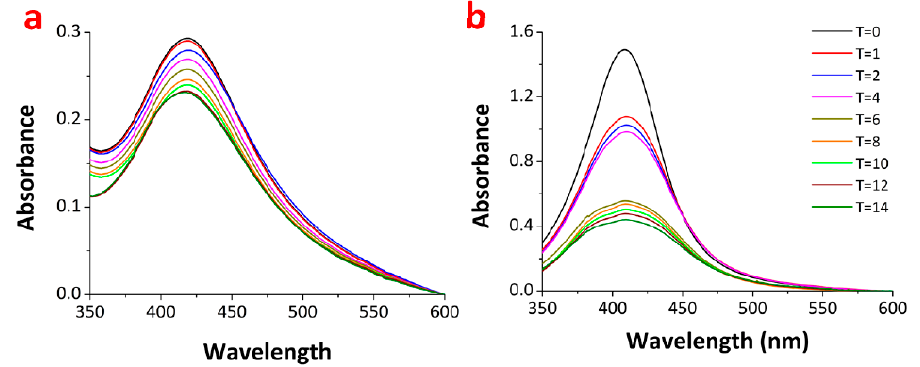
Figure 12. UV-vis spectra of the nanocomposites with the ratio ( 4 ) for the nanocomposites A ( a ) and B ( b ) in PBS at 37 °C for two weeks.